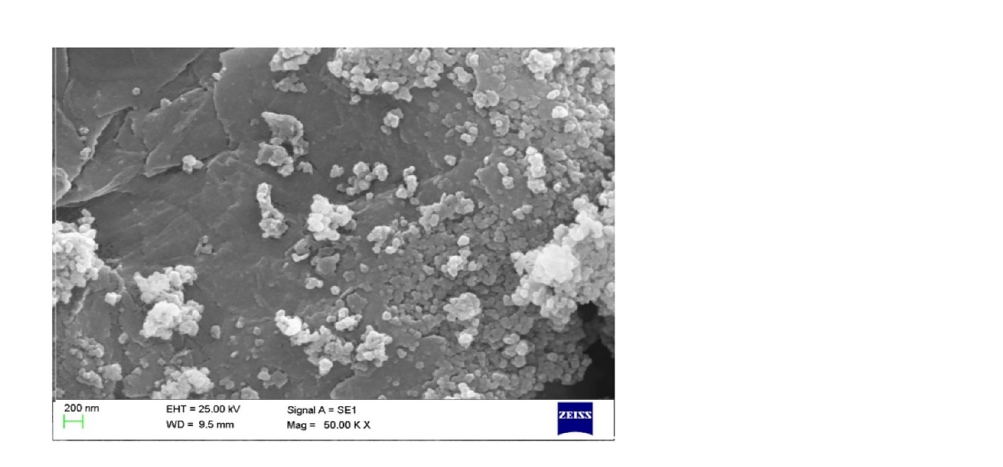
Figure 3. SEM of the Fe 3 O 4 /GO/[FeMo 6